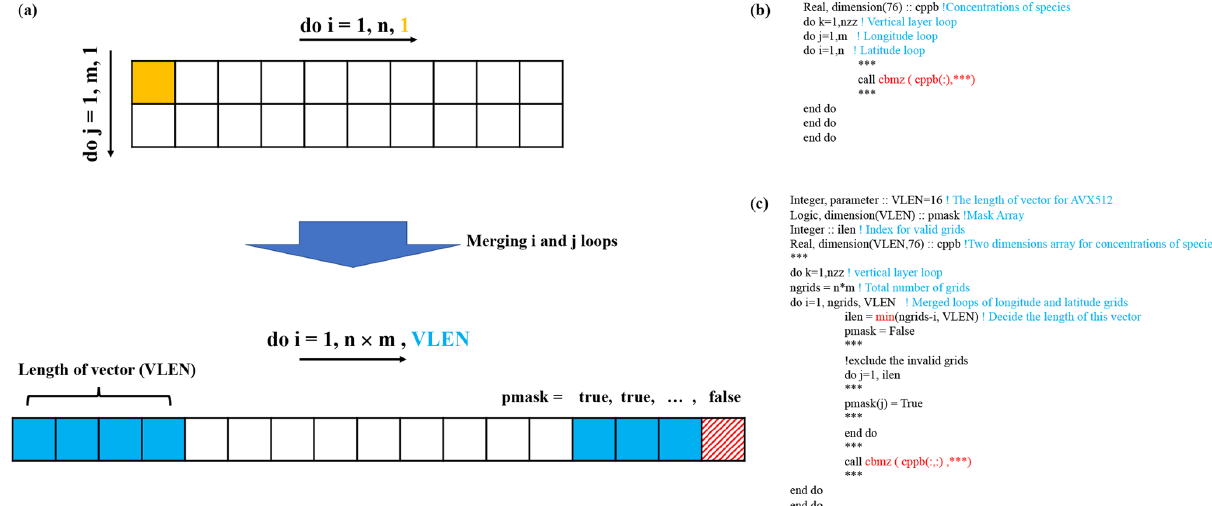
Figure 2. A schematic diagram of the changes in the calling method of CBM-Z. The calling method of the CBM-Z module changes from calculating one model grid calculation at a time to multiple model grid boxes at the same time. The VLEN represents the number of points operated simultaneously, which is determined by the length of the register in the vector processing unit (VPU). The i and j loops, equaling latitude and longitude loops, were merged to construct one vector to reduce the number of unfilled vectors. Panel (b) and (c) illustrate the sample code before and after integrating grid boxes.